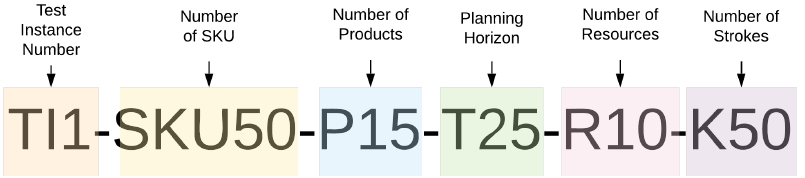
Figure 2. The identification system for test instances [28]. SKU, Stock Keeping